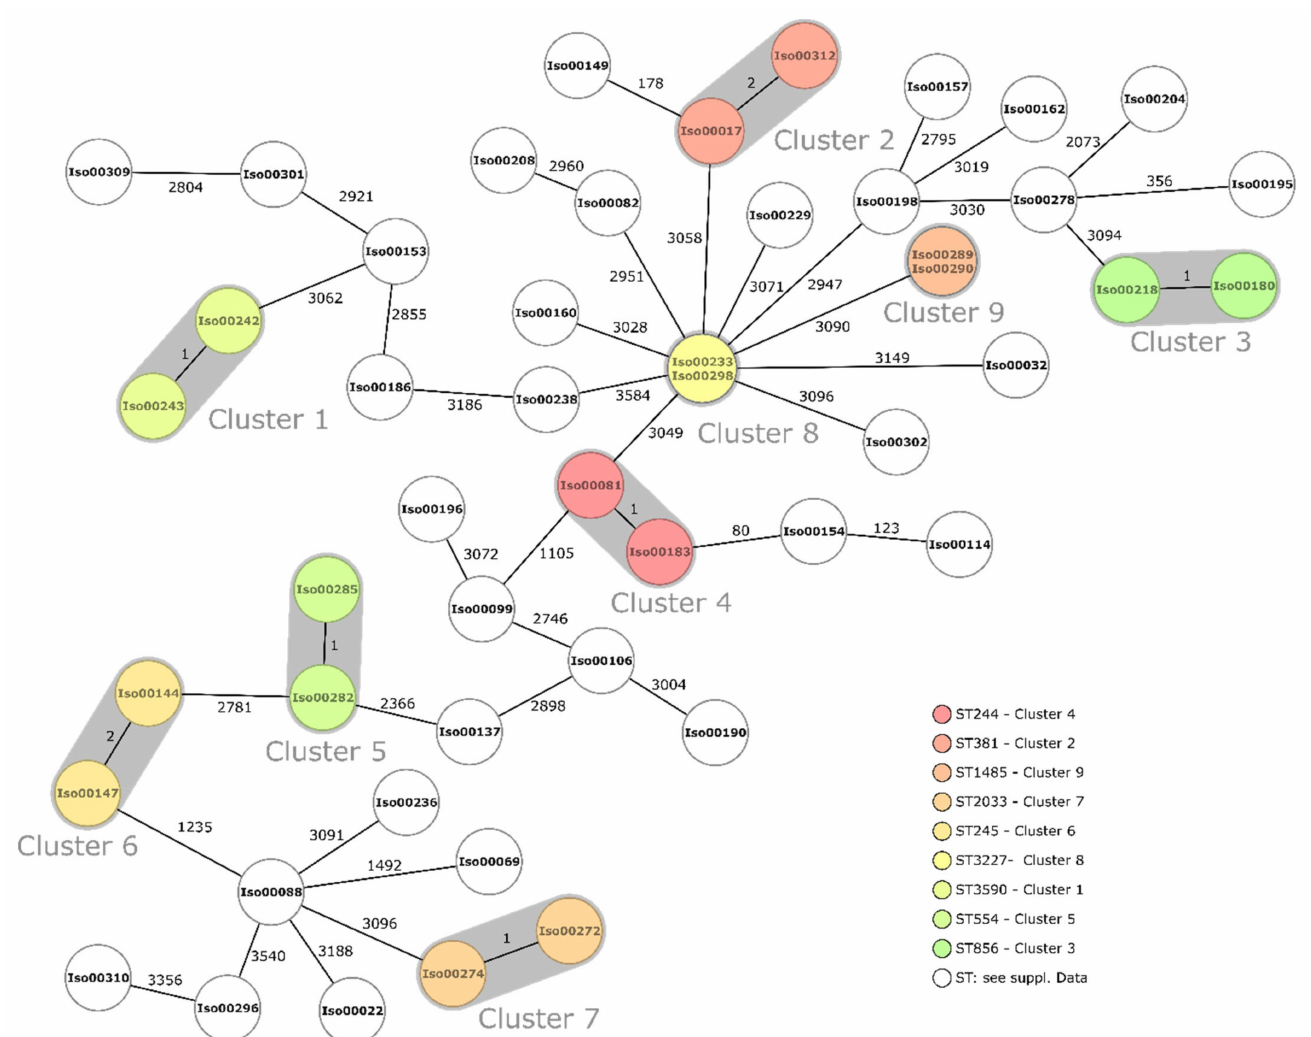
Figure 1. Minimum spanning tree of P. aeruginosa based on 3867 targets (core genome). Isolate numbers are found within the nodes, and numbers between nodes indicate the number of different alleles. Isolates within clusters are colored based on MLST sequence type (ST). The ST types of white nodes are indicated in Table